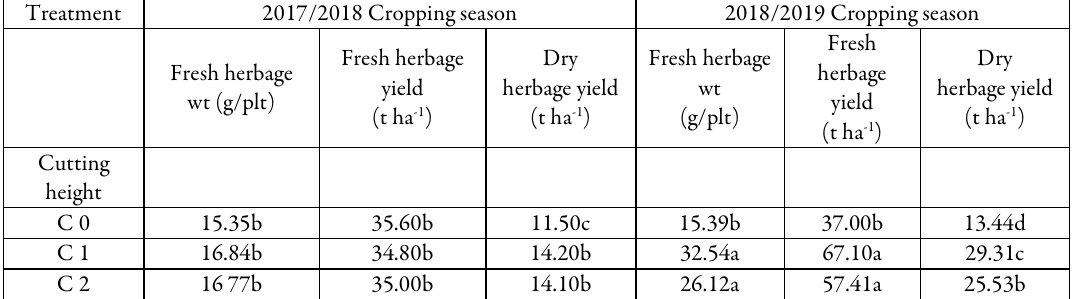
Table 3. Effect of cutting height and fertilizer application on herbage yield of Amaranthus cruentus L . Treatment